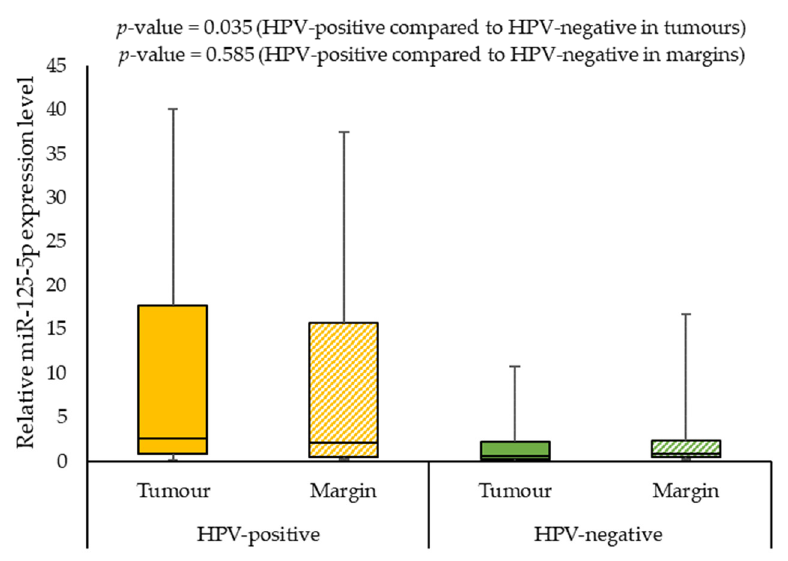
Figure 5. The relative expression level of miR-125b-5p in HPV-positive compared to HPV-negative Figure 5. patients.